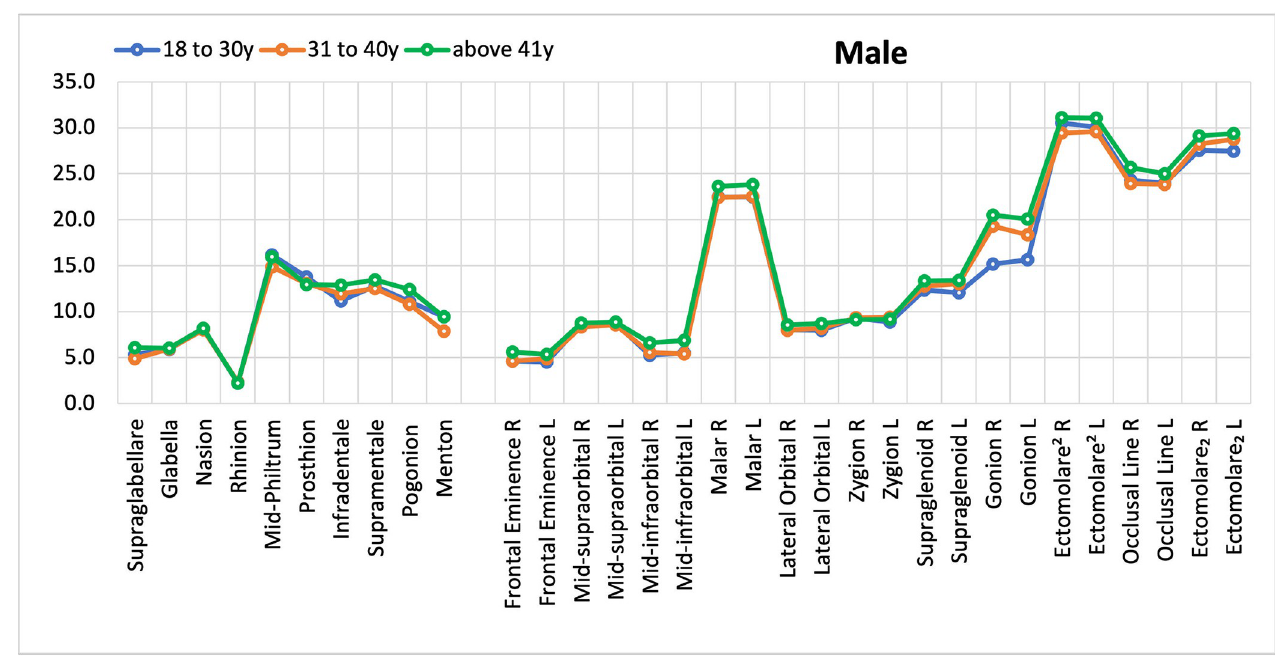
Fig 6. FSTT means: Comparison among age groups in females.